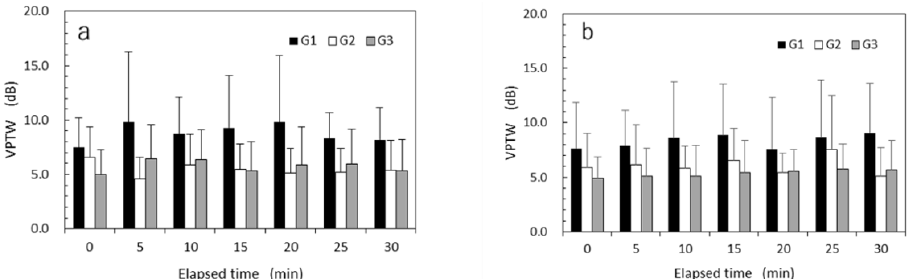
Figure 8. Vibrotactile perception threshold width (VPTW) at a VPT test frequency of 31.5 Hz after